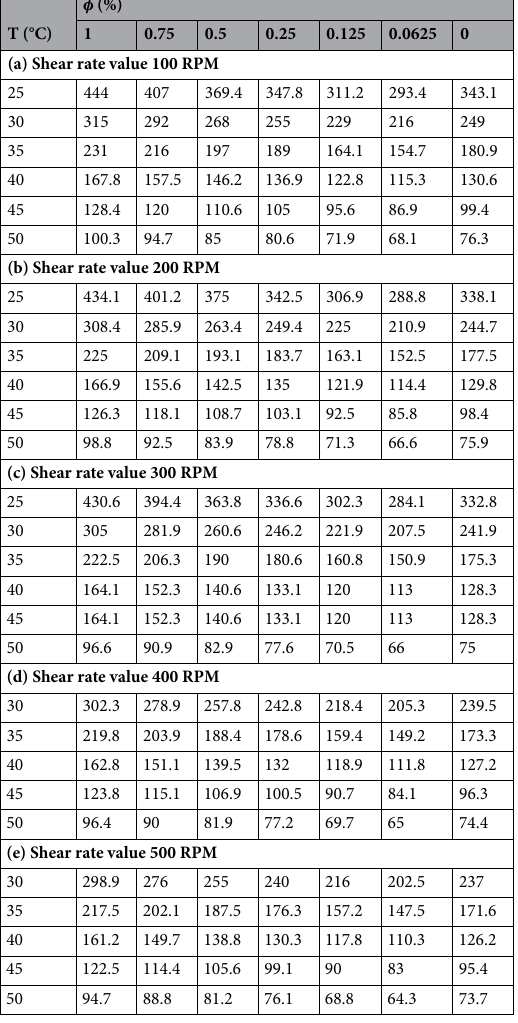
Table 1. µ nf versus temperature with different φ .